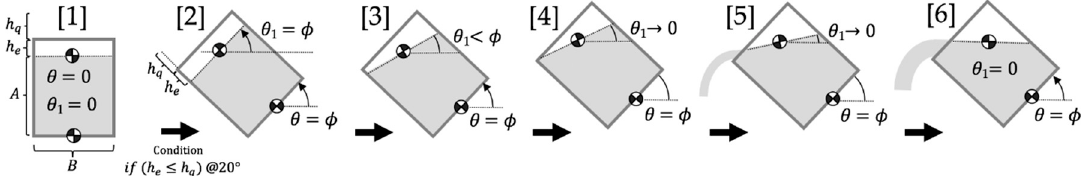
Figure 4. Transitions of AFS with SIM. Transition 1 defines initial conditions in hydrostatic equilibrium where the angle of the pouring vessel and the angle of the free surface are zero. Transitions 2–6 define the slosh induction method steps that run only if the height condition ( ℎ (cid:3032) (cid:3409) ℎ (cid:3044) at 20 ° ) is